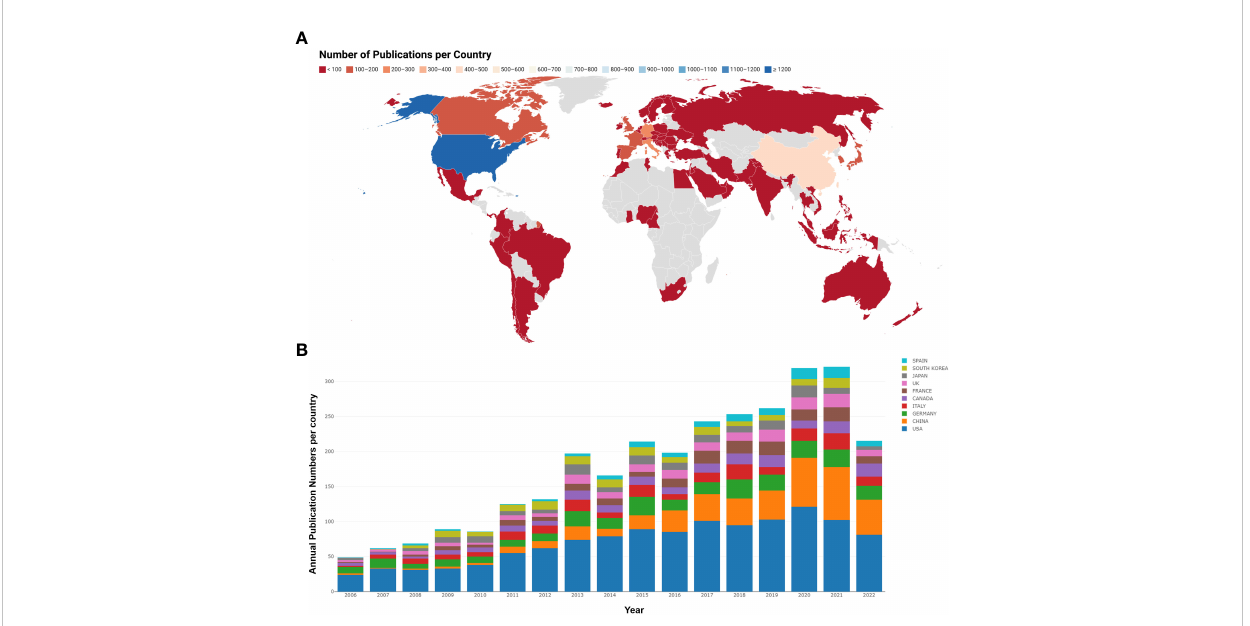
FIGURE 3 Analysis of country based on the number of publications. (A) The number of publications per country. Countries with less publications were colored red, while countries with most publications were colored blue. Countries without publications in the related region were colored gray. (B) The annual publication number and trend of the 10 most productive countries. Different countries were represented by different colors, and the height of each color blot re fl ected the number of publications of a speci fi c country in a speci fi c